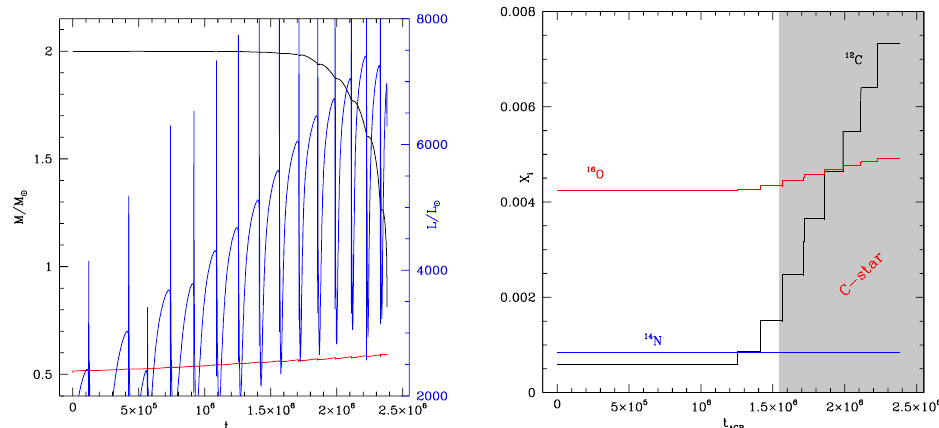
Figure 2. ( Left ) AGB evolution of the total and core mass (black and red lines, scale on the left ) and of the luminosity (blue, scale on the right ) of a 2 M (cid:12) model star of metallicity Z = 8 × 10 − 3 . ( Right ) variation of the surface CNO mass fractions; the grey-shaded area indicates the C-star